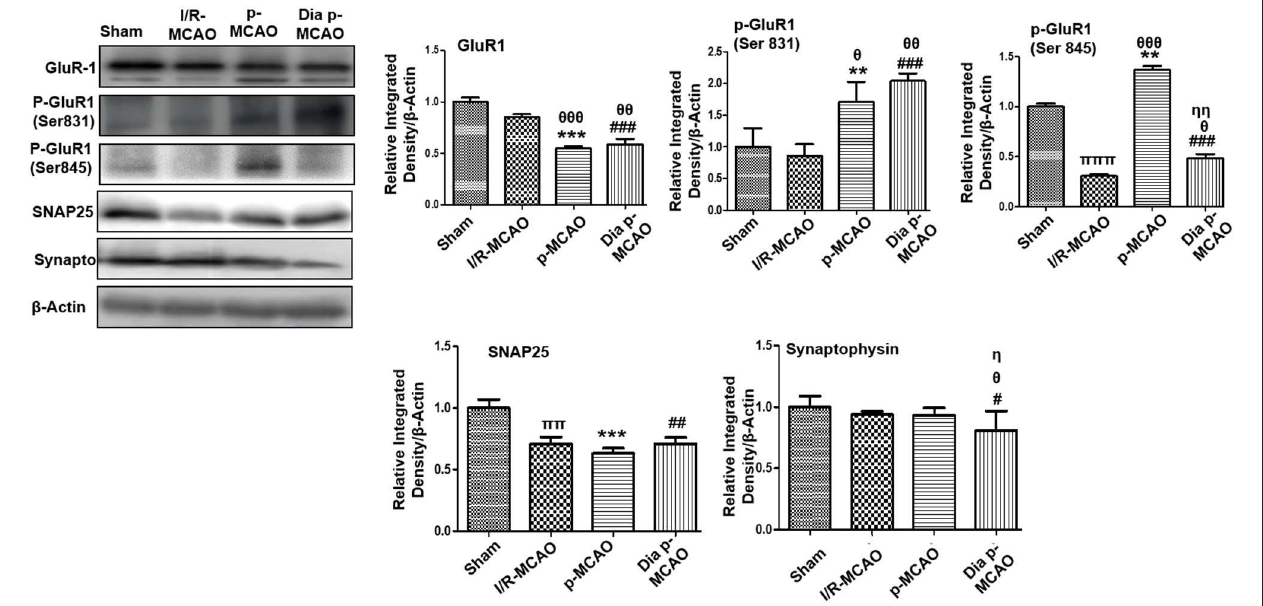
FIGURE 4 | Expression of glutamate neurotransmission and synaptic changes in various ischemic models western blot analysis of GluR1, p-GluR1 (Ser845, Ser831), SNAP25, Synaptophysin. Densitometric analysis was expressed in relative to β -Actin ( n = 5/group). θ p < 0.05 relative to I/R MCAO, η p < 0.05 between p-MCAO and Dia p-MCAO. * p < 0.05, # p < 0.05, and π p < 0.05 relative to sham group. *** p < 0.001, ** p < 0.01, ### p < 0.001, and ## p < 0.01. θθ shows significant difference of p-MCAO and Dia p-MCAO to I/R, and its value is p < 0.01, θθθ shows significant difference of p-MCAO and Dia p-MCAO to I/R, and its value is p < 0.001, ππ shows significant difference of I/R MCAO to sham, and its value is p < 0.01, πππ shows significant difference of I/R MCAO to sham, and its value is p < 0.001, ηη shows significant difference between p-MCAO and Dia p-MCAO, and its value is p <